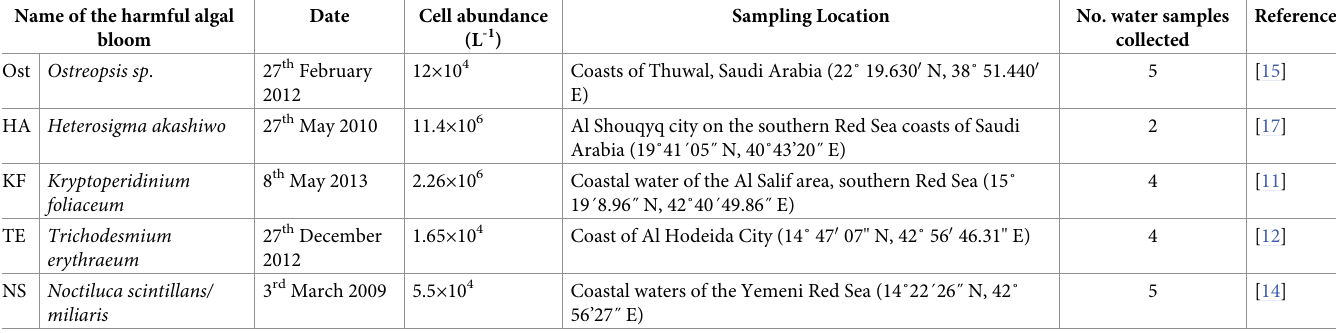
Table 2. Summary of the different types of harmful algal blooms (HABs) reported by various studies in the Red Sea. Name of the harmful algal Date Cell abundance Sampling Location No. water samples bloom (L -1 )